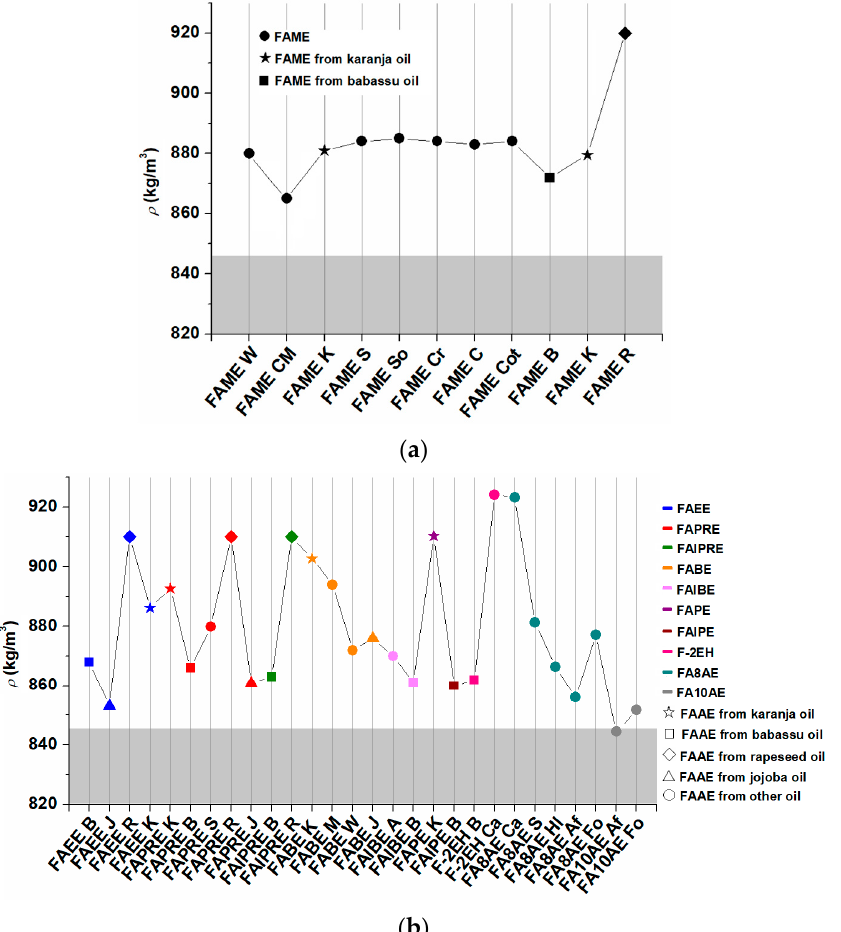
Figure 1. Literature densities of different FAAE: ( a ) FAME from different triglyceride sources, and ( b ) fatty acid alkyl (C 2+ ) esters from different triglyceride sources (values and corresponding references are given in Table 2).